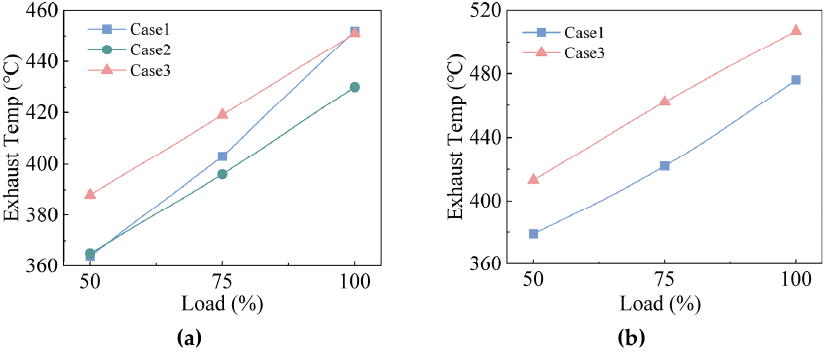
Figure 11. The trend of exhaust temperature for variable EBP at different loads. ( a ) EBP = 10 kPa; ( b ) EBP = 25 kPa. ( b ) EBP = 25